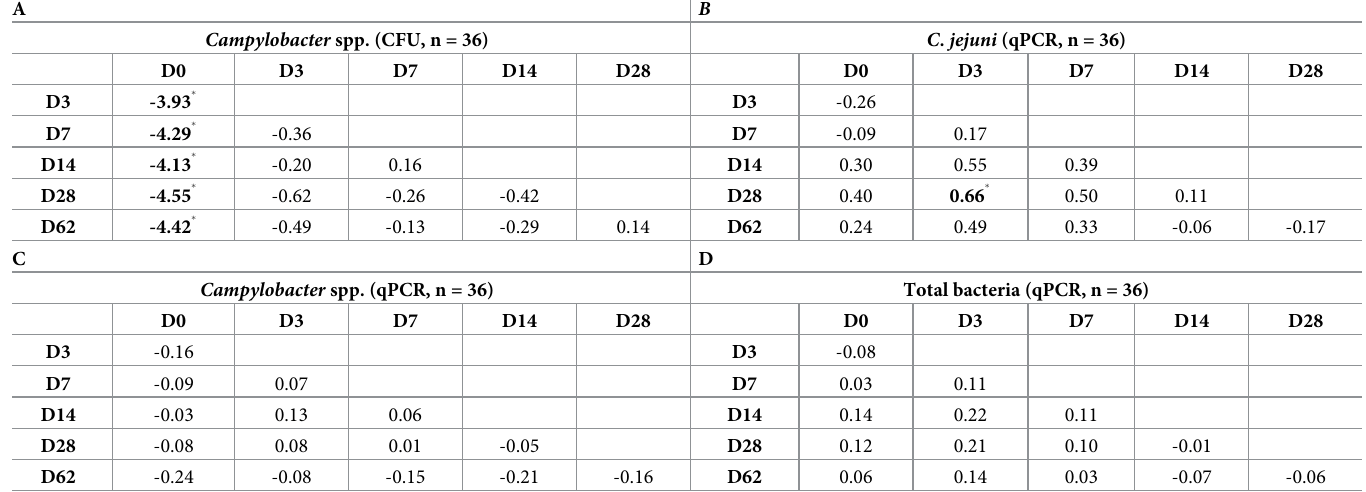
Table 3. Time-point Log 10 bacteria/g differences amongst different analyses (i.e., columns -rows and letters from A to D). Statistically significant differences are indicated in bold and with the symbol " � ". A